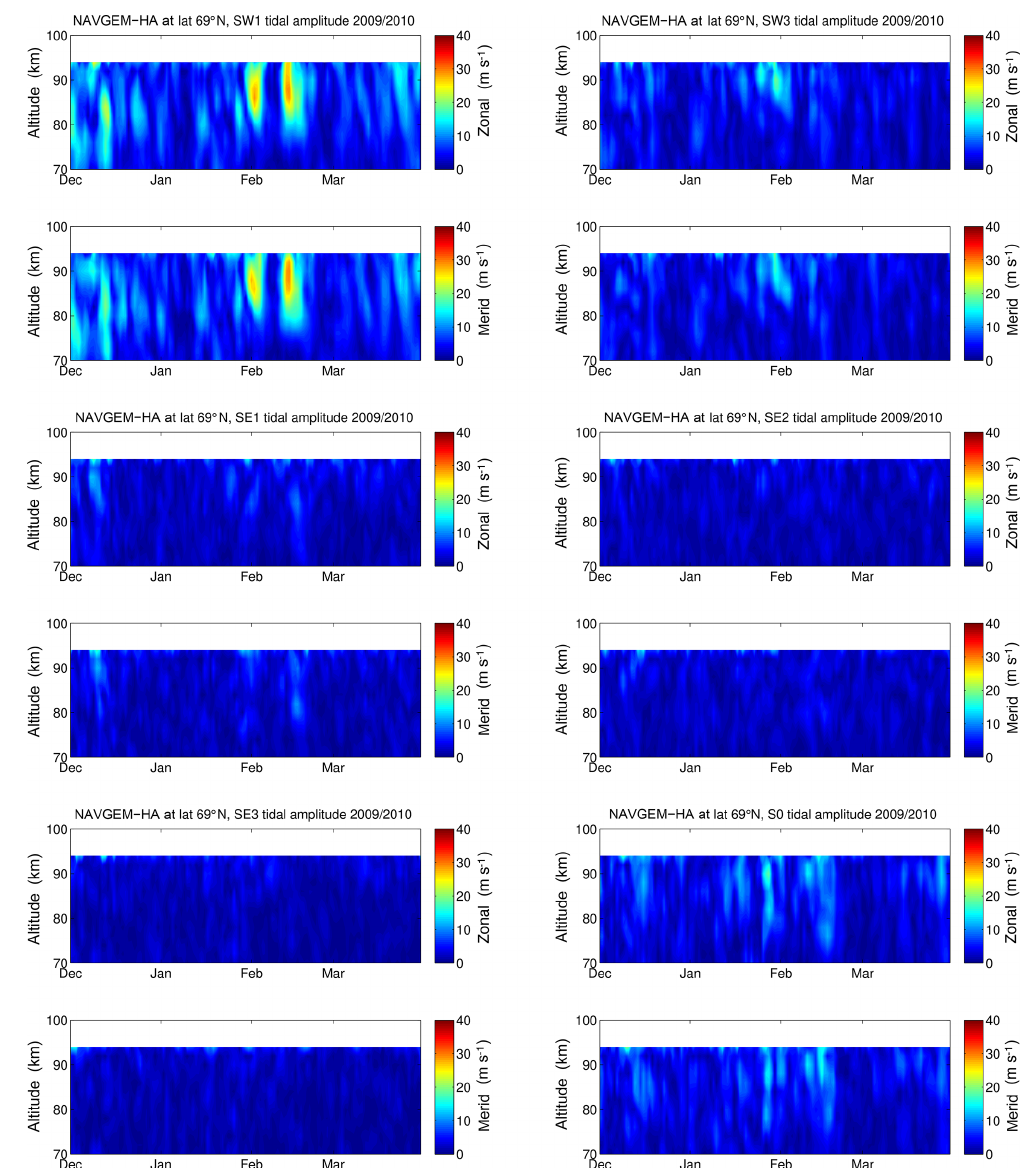
Figure B1. Non-migrating tides derived from global NAVGEM-HA winds above Andenes during the winter of 2009/10 for SW1 and SW3 (two upper panels), SE1 and SE2 (middle panels), and SE3 and S0 (two lower panels) tidal components.